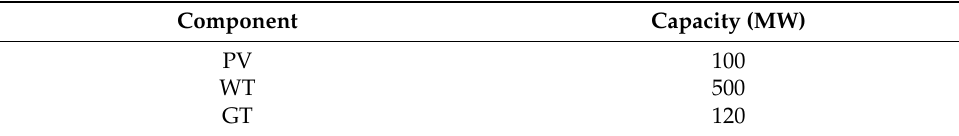
Table 5. The capacity of PV, WT, and